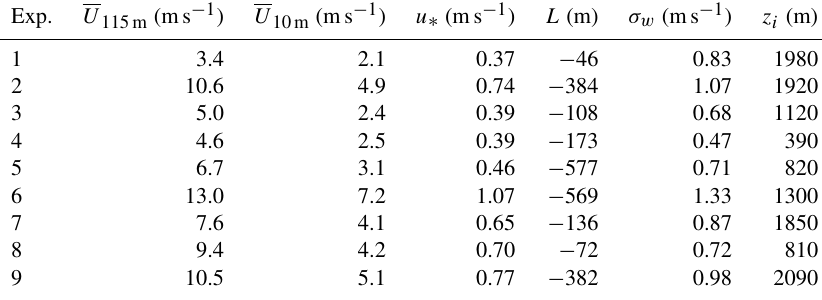
Table A1. Meteorological conditions during the Copenhagen dispersion